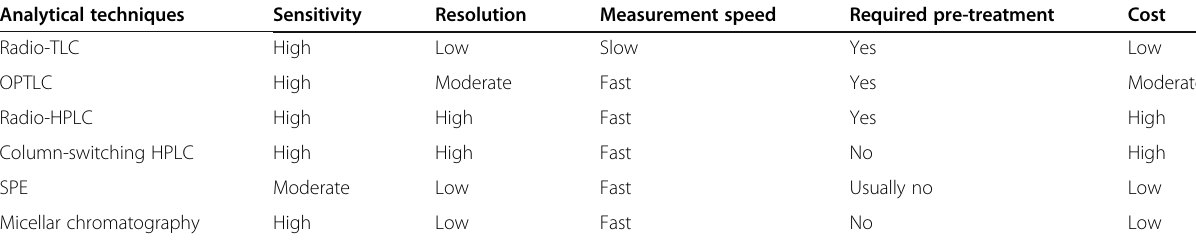
Table 2 Advantages and limitations of different analytical techniques applied to radiometabolite analysis Analytical